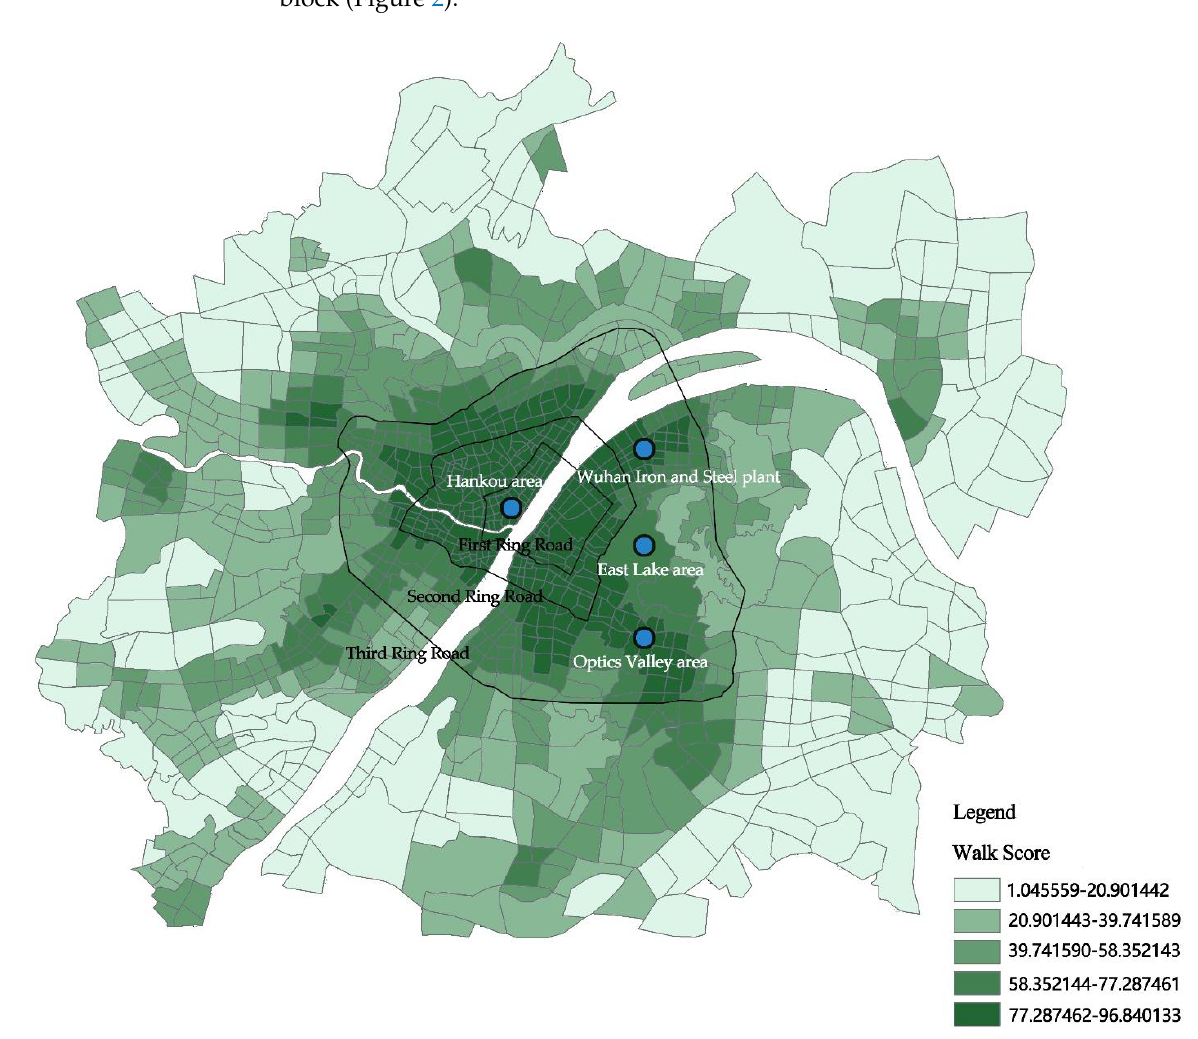
Figure 2. Wuhan metropolitan area walking index score.